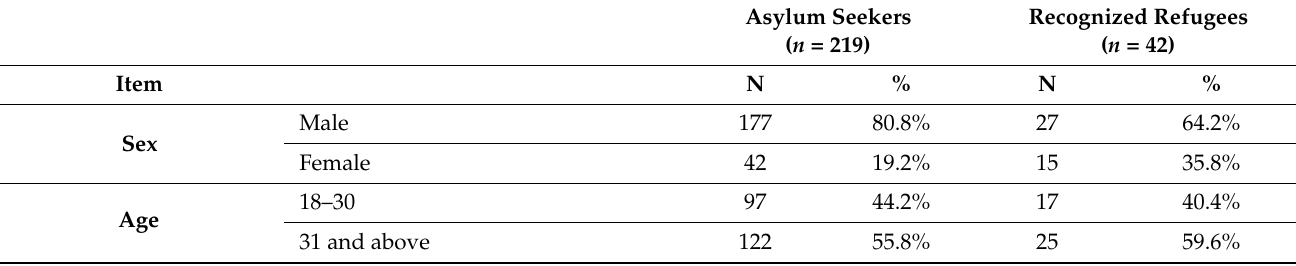
Table 2. Participants’